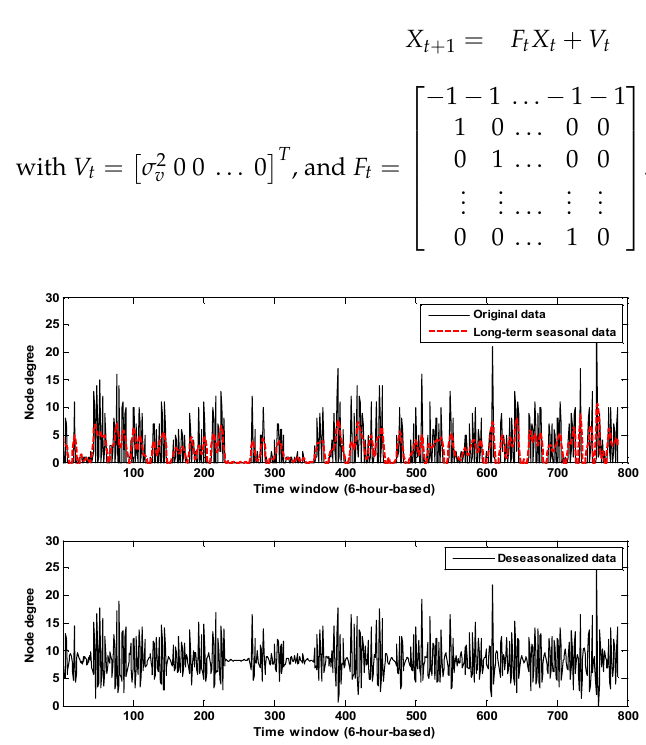
Figure 5. ( upper ) Long-term seasonal data, and ( lower ) deseasonalized data of the hub node’ degree